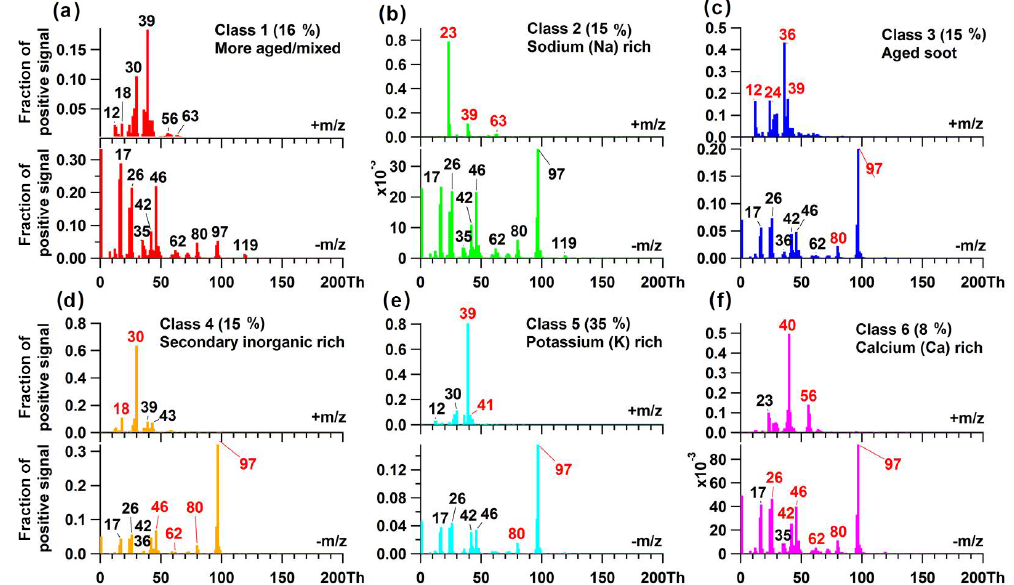
Figure 8. Mass spectra for six classes of particles measured on 29 July 2016 during the field campaign TRAM01, based on classification according to the fuzzy c -means algorithm. The percentage in each pair of spectra ( a to f ) gives us information about the similarity of the total aerosols to different classes. The red tags represent the signatures for each typical class, but there is no red tag in (b) , since this class consists of more aged particles containing signatures for different classes. Mean particle size: d va (676 ±